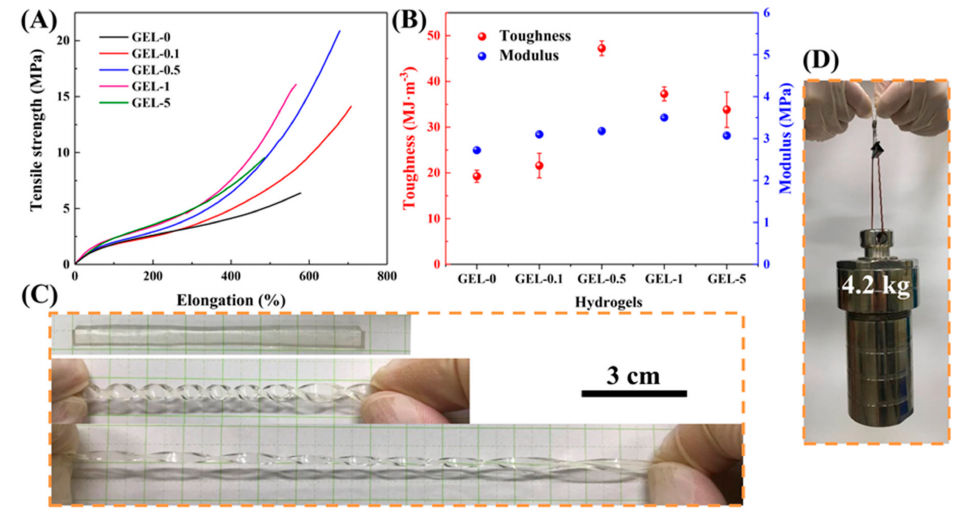
Figure 3. ( A ) Tensile curves of CDN-gels; ( B ) toughness and Young’s modulus of CDN-gels; ( C ) twisting and stretching after being twisted for GEL-0.5; and ( D ) carrying a heavy steel block weighing 4.2 kg using GEL-0.5 (width = 4 mm, thickness = 2